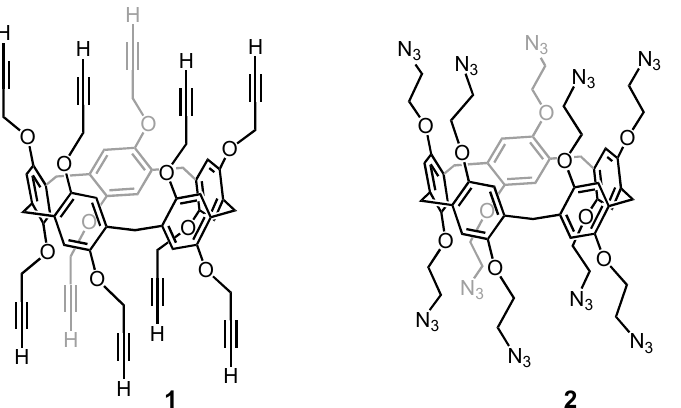
Figure 2. Typical examples of clickable pillar[5]arene derivatives used for the construction of mul- tifunctional nanomaterials.